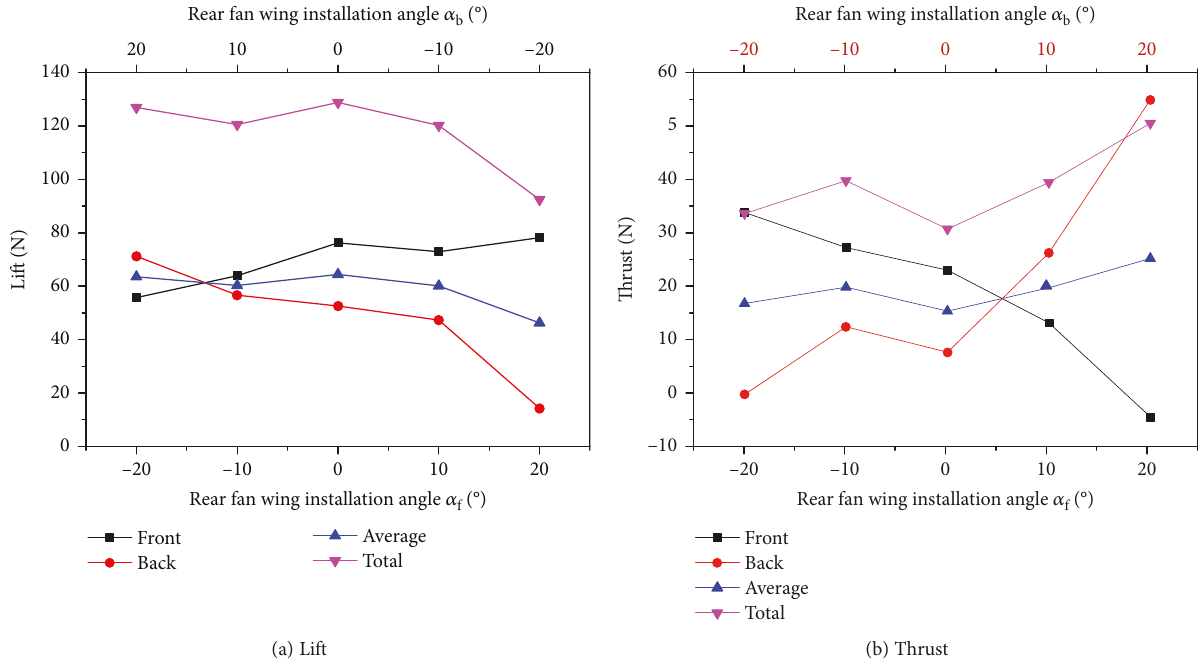
Figure 18: Curve of the lift and thrust of the front and rear fan wings when the front and rear wings have the opposite installation